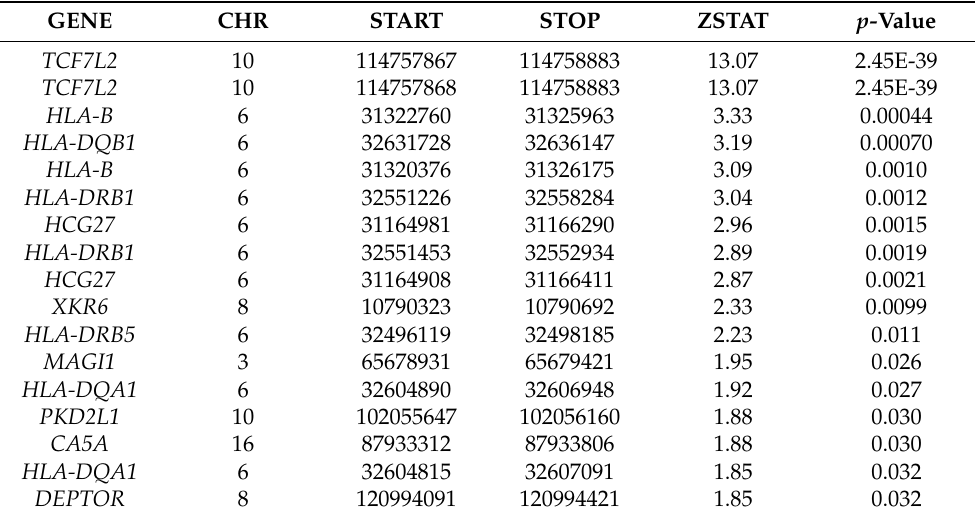
Table 4. T2D-associated genetic variant loci with overlap regions of H3K9ac changes. GENE CHR